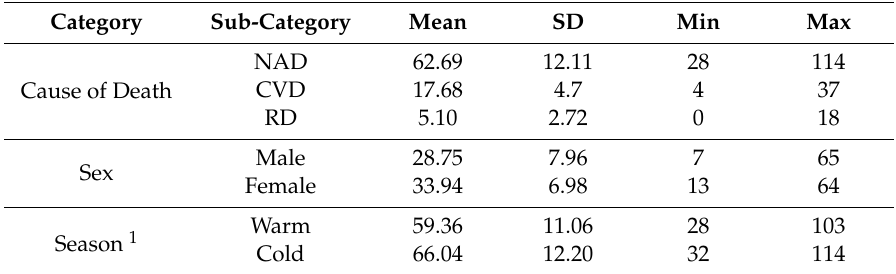
Table 1. Summary statistics of daily mortality of elderly ( ≥ 65 years) by cause of death, sex, and season in Seoul, South Korea (1994–2014).